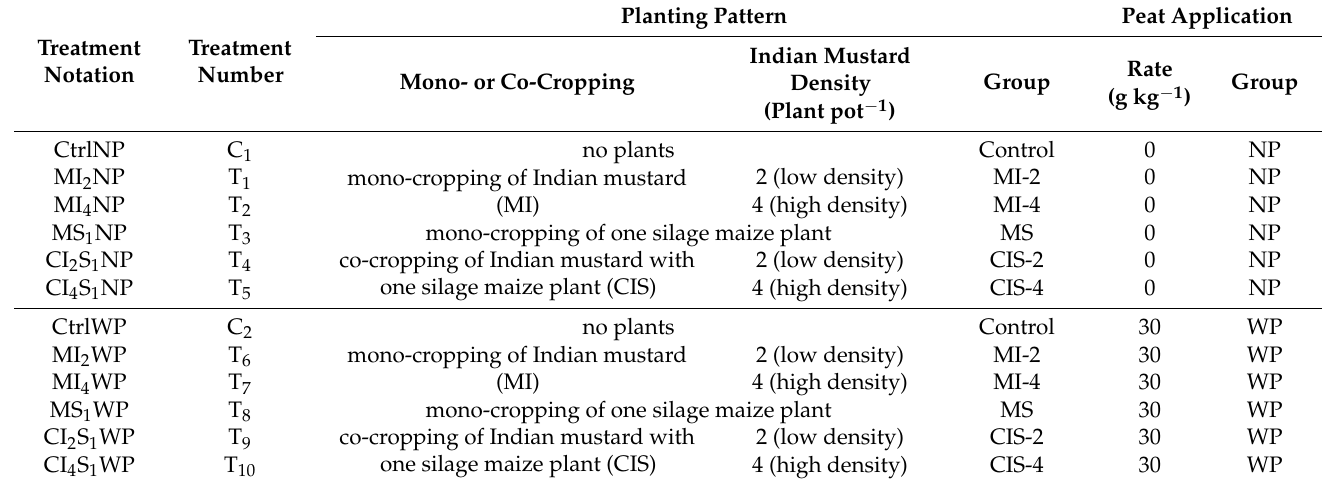
Table 2. The notations of treatments and their